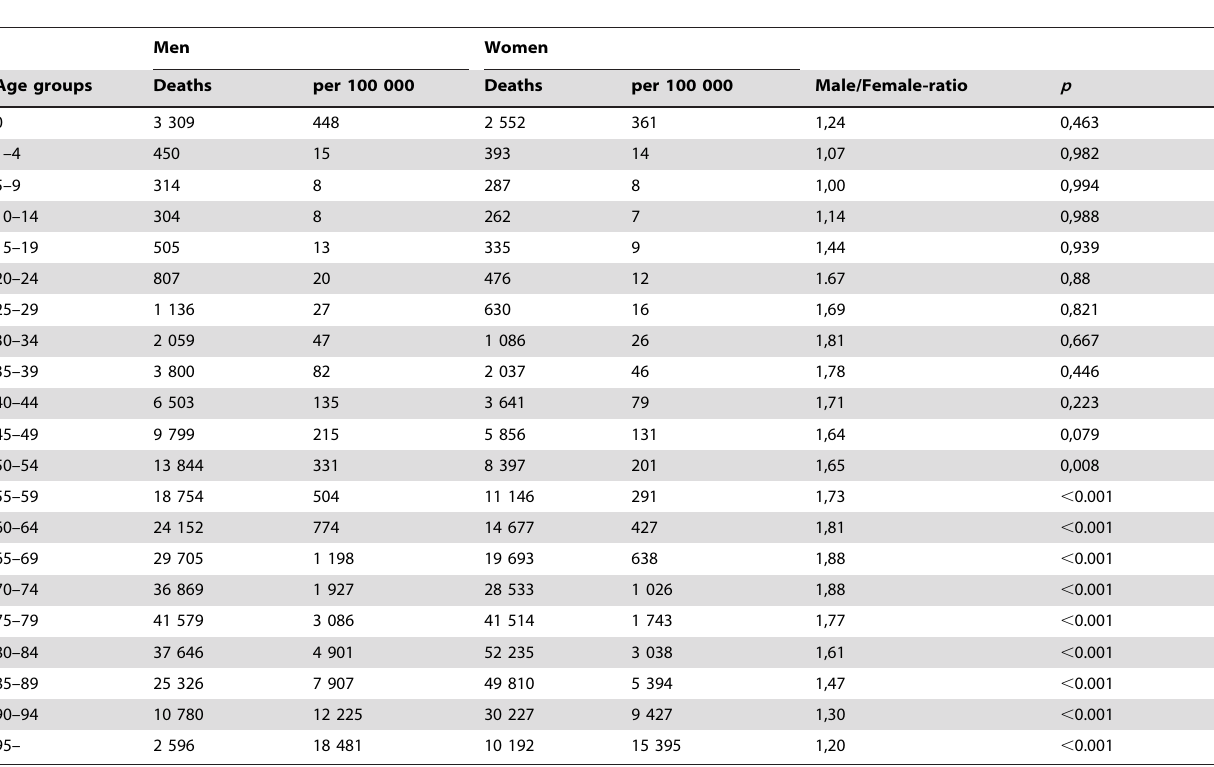
Table 4. Mortality from non-vascular diseases among men and women by age, Finland 1986–2009.